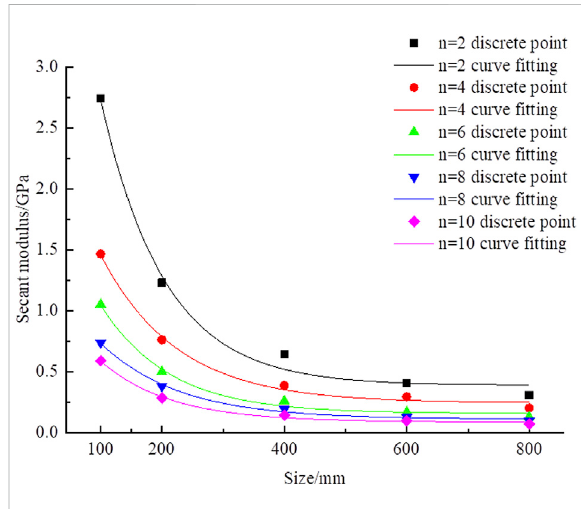
FIGURE 5 Fittingcurveofthesecantmodulusunderdifferentrocksizes.